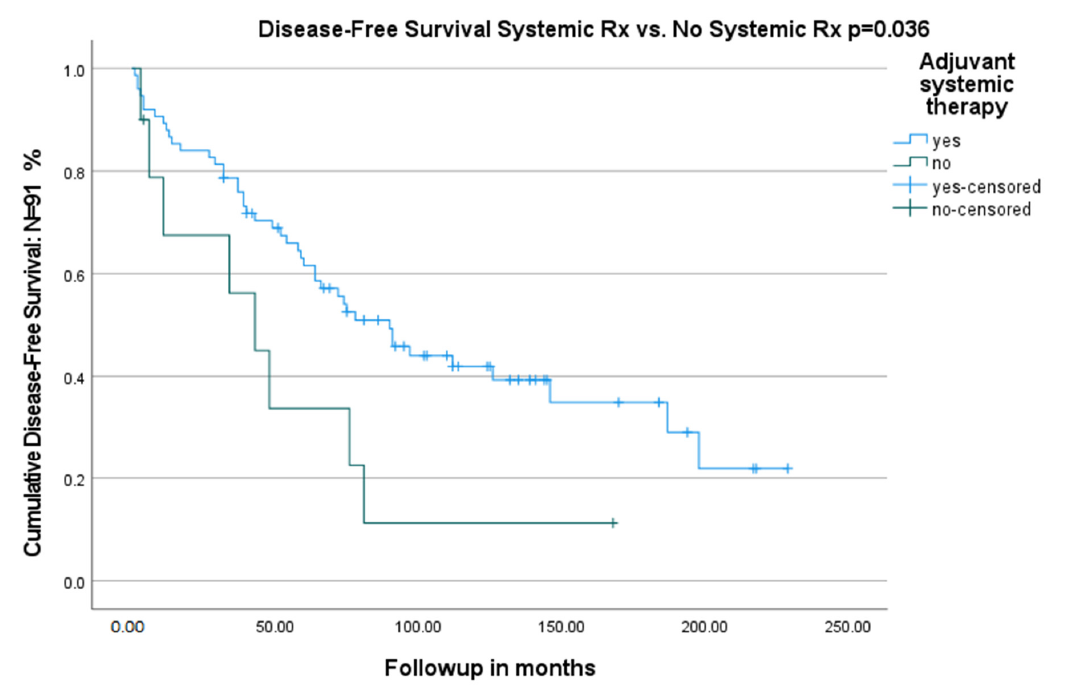
Figure 3. Kaplan–Meier disease-free survival curves based on adjuvant systemic therapy for 91 patients with early-stage invasive breast cancer that showed patients who received adjuvant systematic therapy have a significantly better disease-free survival ( p = 0.036).